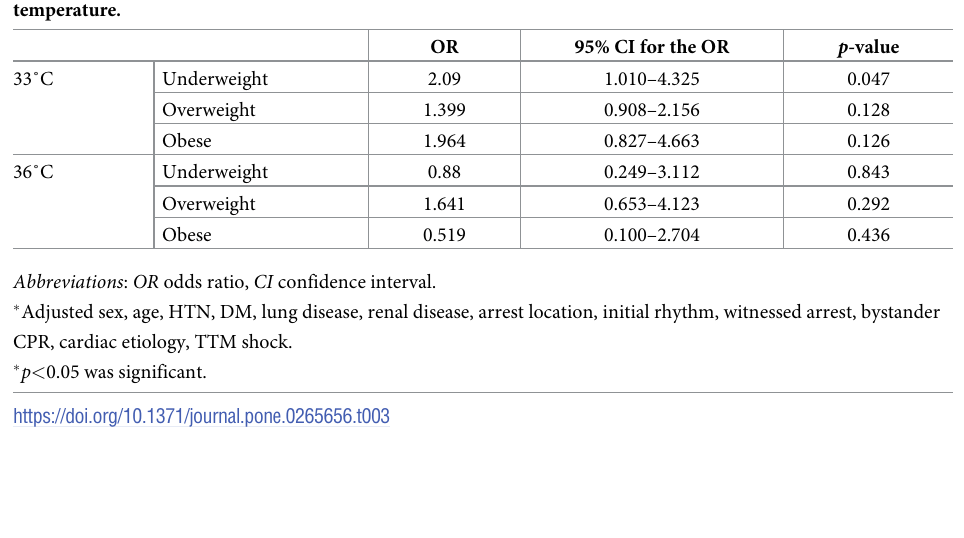
Table 3. Comparison of odds ratios by body mass index group for poor neurologic outcomes based on the target temperature.